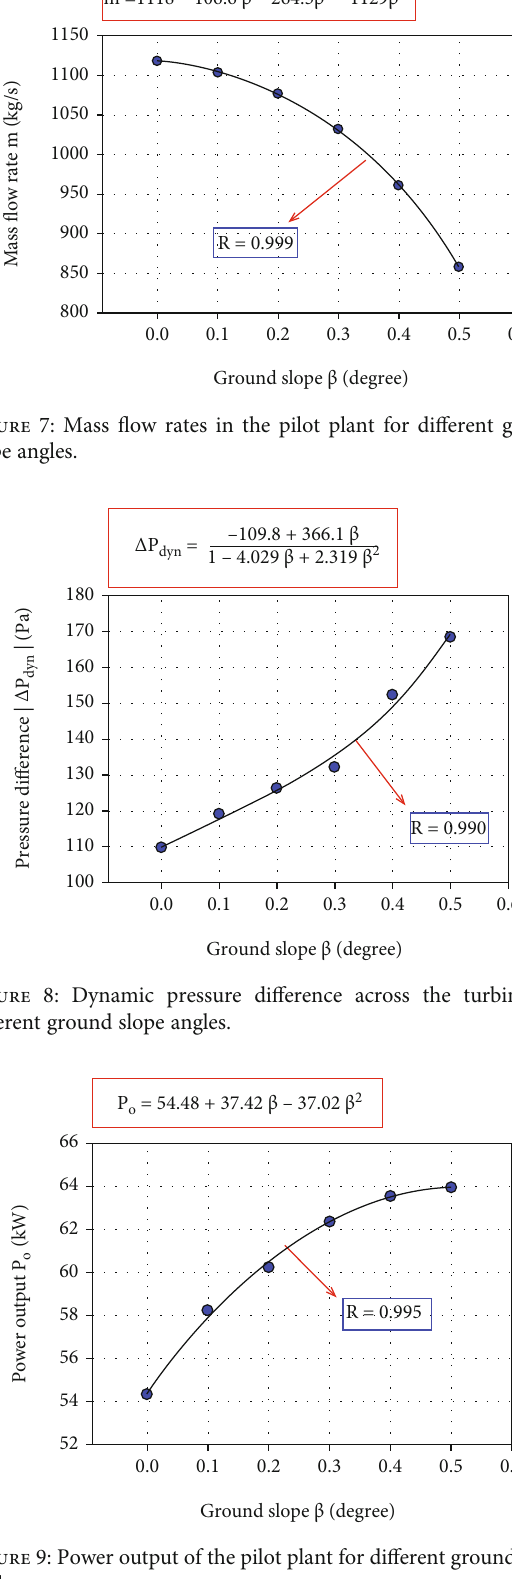
Table 5: Rayleigh number for 0 and 0.2 ° ground slope.